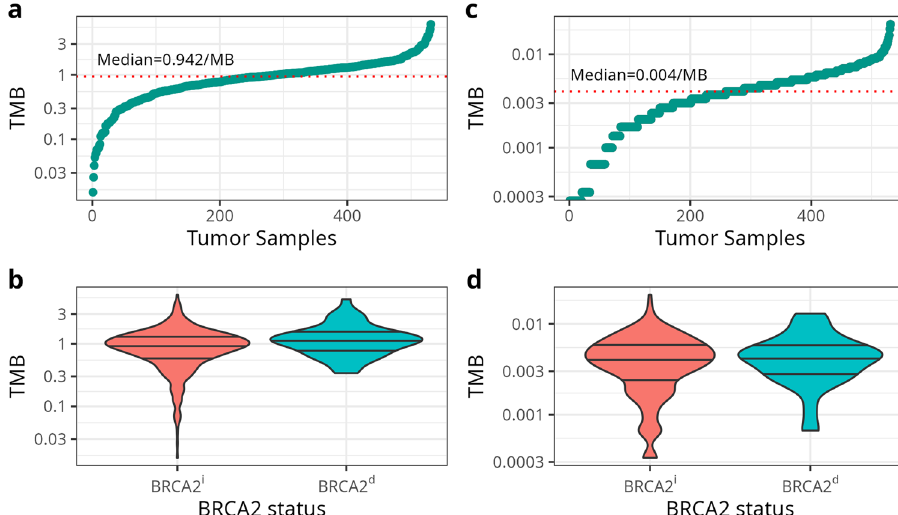
Fig. 2 Tumor Mutational Burden (TMB) (mutations per megabase) in primary BRCA2 -de fi cient and BRCA2 -intact tumor samples. Panels display a the distribution of total TMB in all tumors, b the distribution of total TMB by BRCA2 status, c the distribution of pathogenic TMB in all tumors, and d the distribution of pathogenic TMB by BRCA2 status. TMB is estimated from samples with whole genome sequencing from the ICGC dataset ( n = 531). In panels b and d, the lower, middle, and upper lines correspond to the lower quartile, median, and upper quartile of TMB, respectively. P -values are from a two-sided Wilcoxon rank-sum test. BRCA2 d BRCA2 -de fi cient; BRCA2 i BRCA2